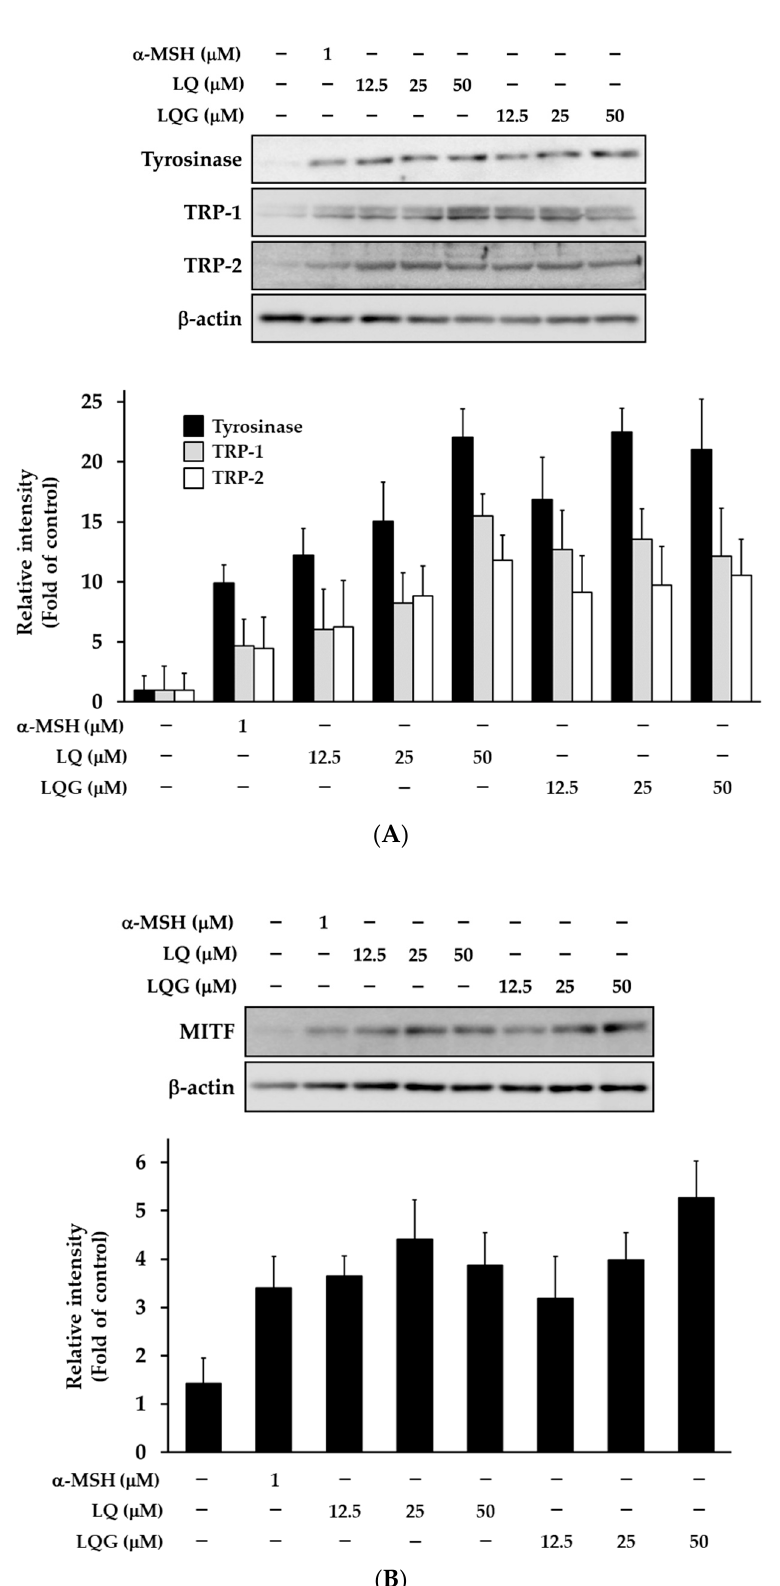
Figure 4. Effects of LQ and LQG on the protein levels of melanogenic enzymes ( A ) and MITF ( B ). B16-F1 cells were treated with LQ, LQG, or α -MSH at the indicated concentrations for 48 h, and the protein expressions of melanogenesis-related proteins and MITF were determined using Western blotting as described in Materials and Methods. The data shown are representative of 4–6 independent experiments.